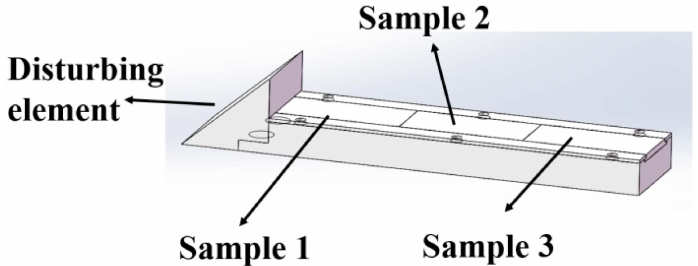
Figure 6. The metallic material samples at different